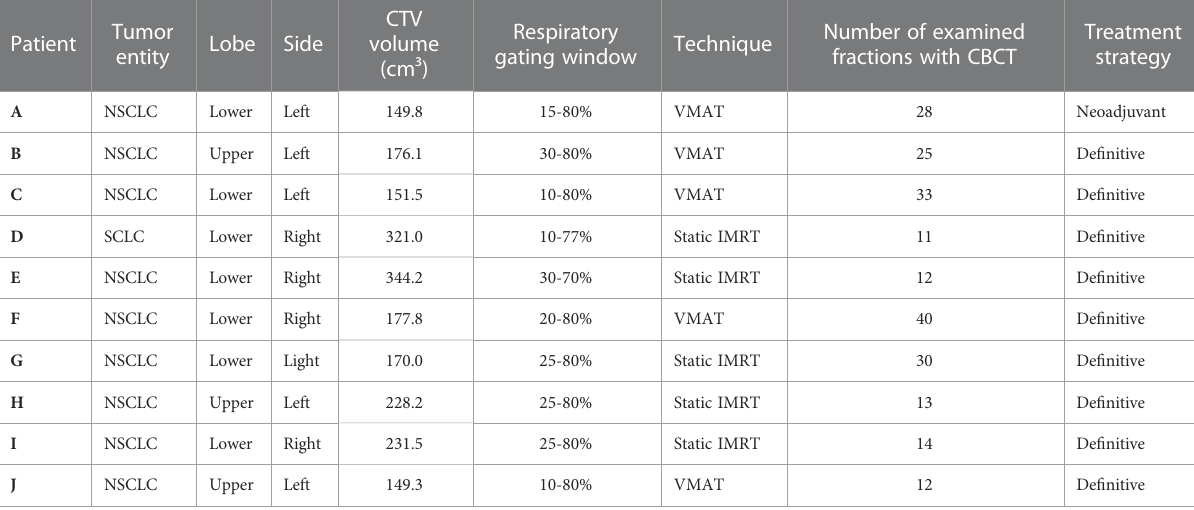
TABLE 1 Tumor characteristics and radiotherapy technique.